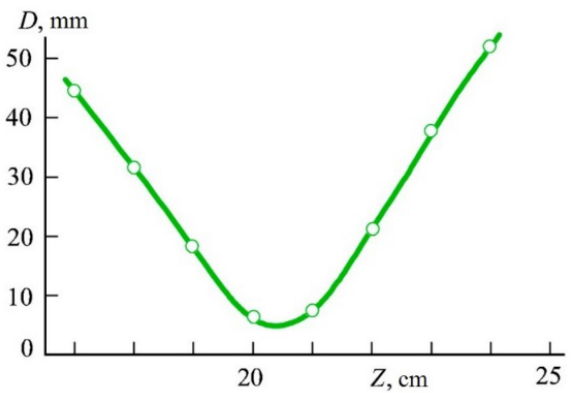
Fig. 4. The formation of a step on the surface of the target installed at a distance z from the grid, due to bombardment with a beam of fast argon atoms.